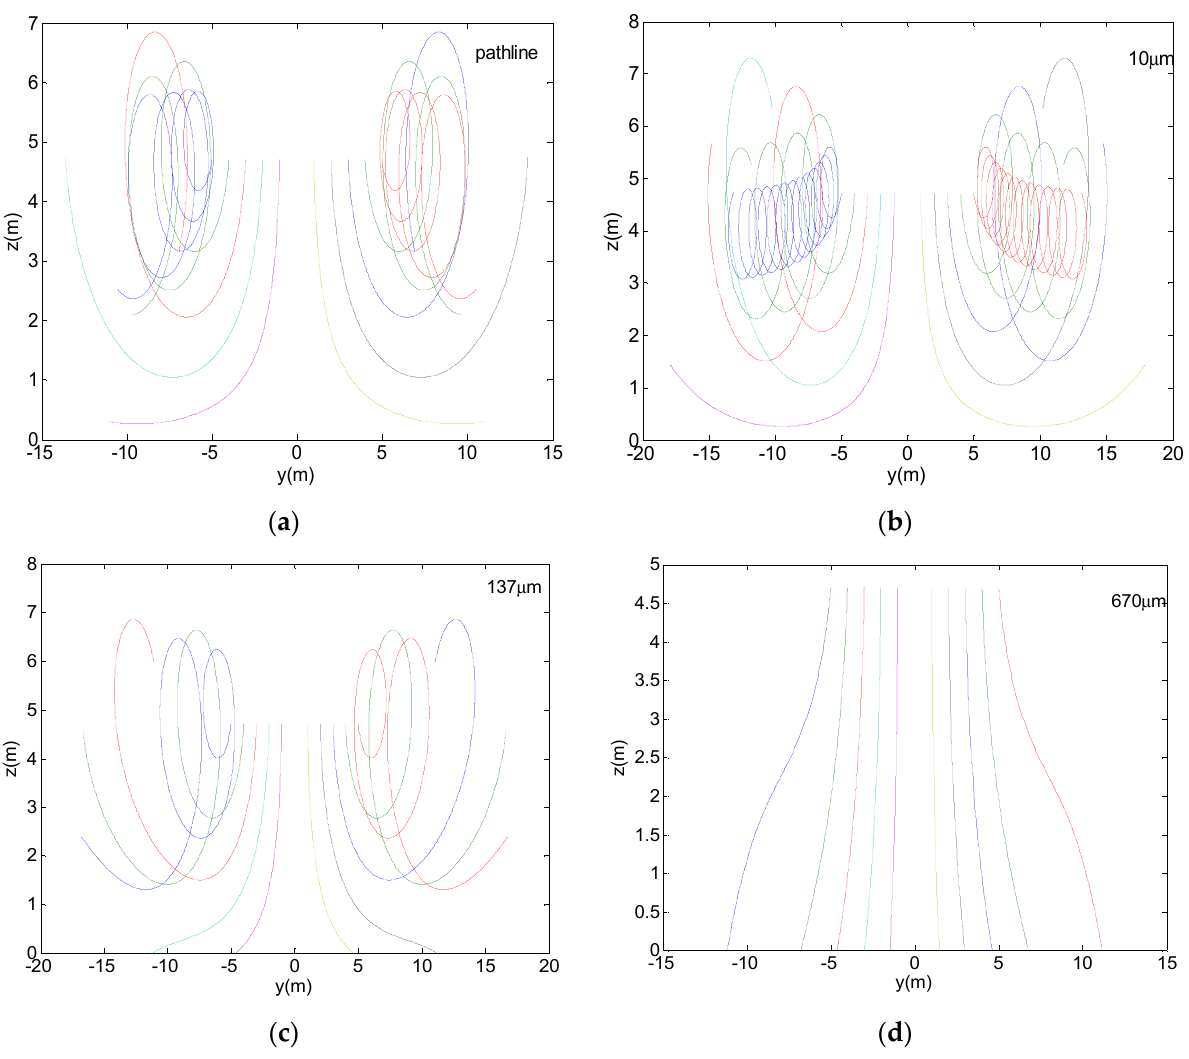
Figure 14. Trajectories of starboard primary and secondary vortices.